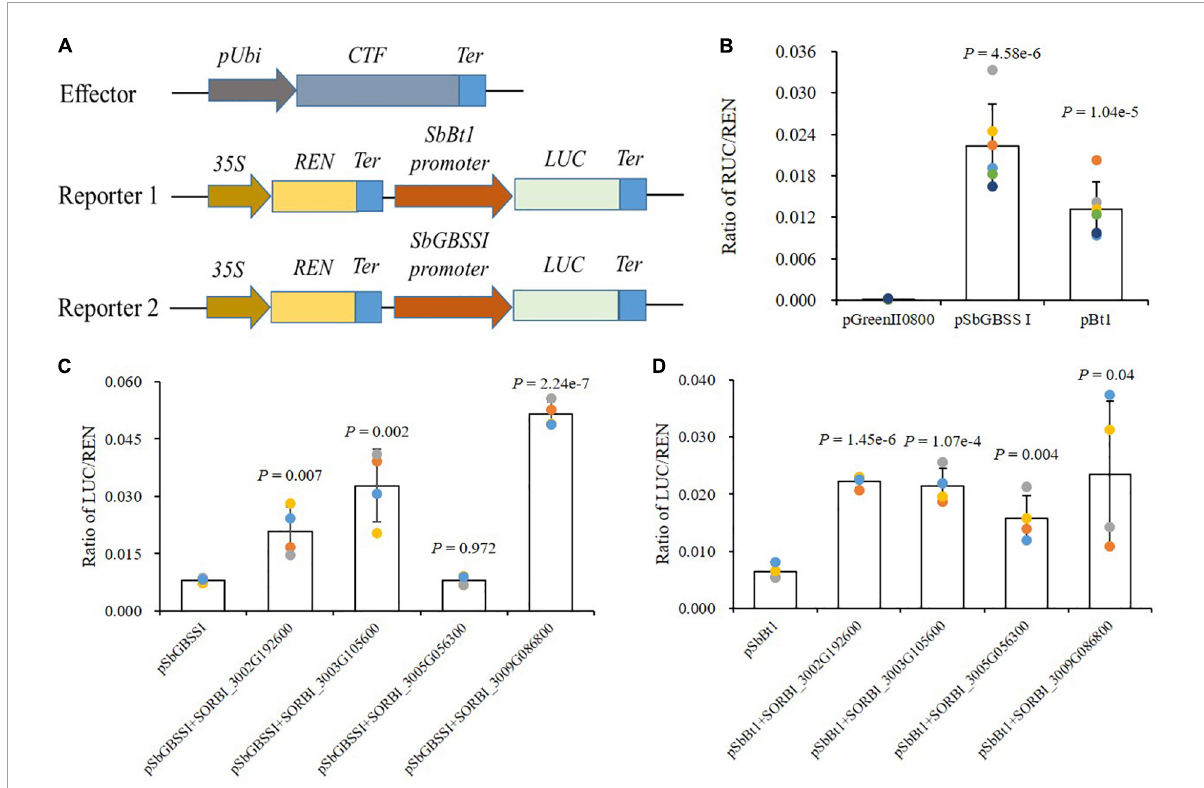
FIGURE7 NAC-type TFs directly stimulate the promoter activities of SbBt1 and SbGBSSI . (A) The schematic diagram of the effector and reporter vectors for dual-luc assays. pUbi, promoter of Ubiquitin ; CTF, candidate transcription factor; LUC, Firefly luciferase; REN, Renilla luciferase; Ter, Terminator. (B) Detection of promoter activities of SbBt1 and SbGBSSI . (C , D) Effect of NAC-type TFs on promoter activities of SbBt1 (C) and SbGBSSI (D) , “+” means the co-transformation of the promoter (before +) and NAC TFs (after +). Dots indicate biological replications. Error bars indicate the S.D. of biological replications. P -values are determined by Student’s t-